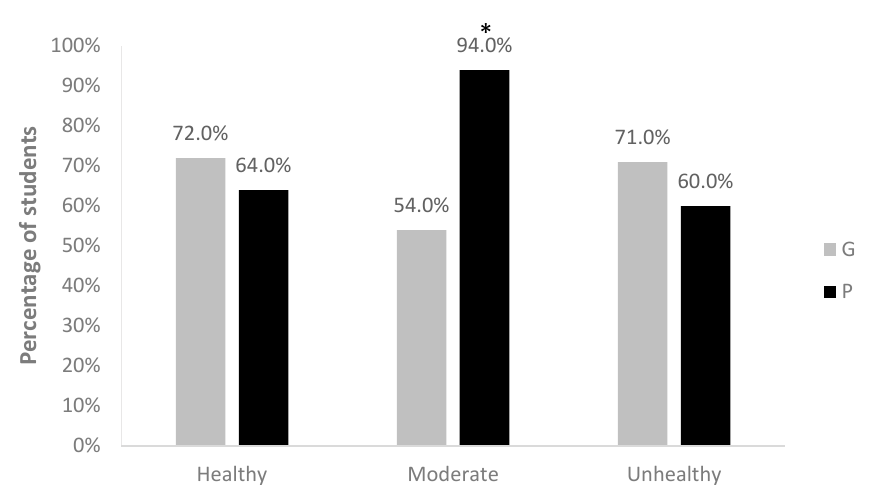
Figure 4. Percentage of students correct in grading the healthfulness of their own recipe, as determined by a dietician, in private (P) and government (G) schools. * Difference between P and G is statistically significant at p < 0.001.